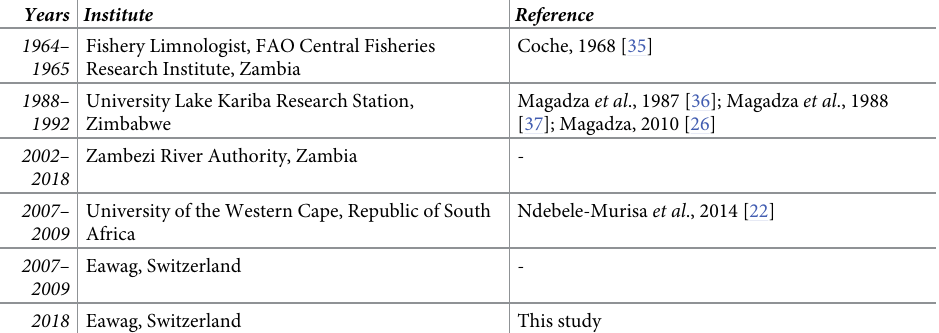
Table 2. Data sources. Overview of the data sources of observed vertical profiles of water temperature and dissolved oxygen included in this